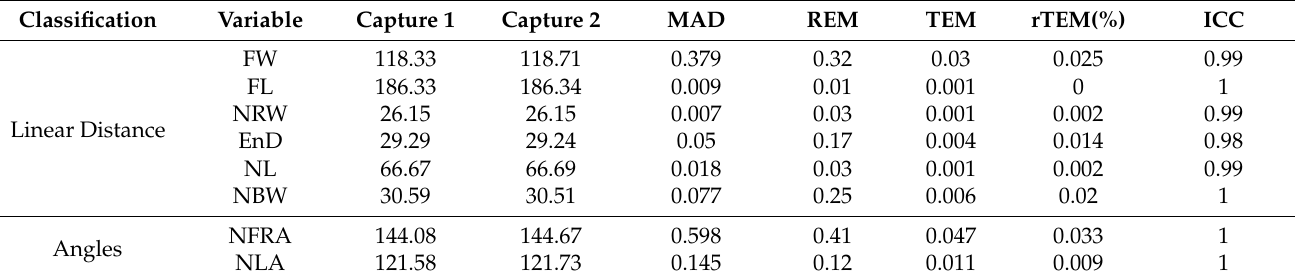
Table 7. The intra-method reliability of classic